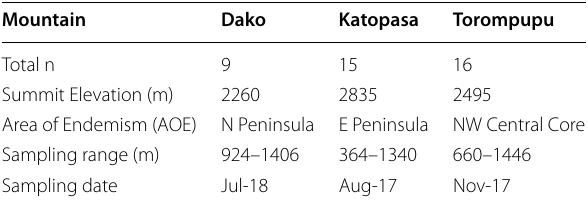
Table 2 Sampling site information for Pellornuem celebense cloacal swabs used in this